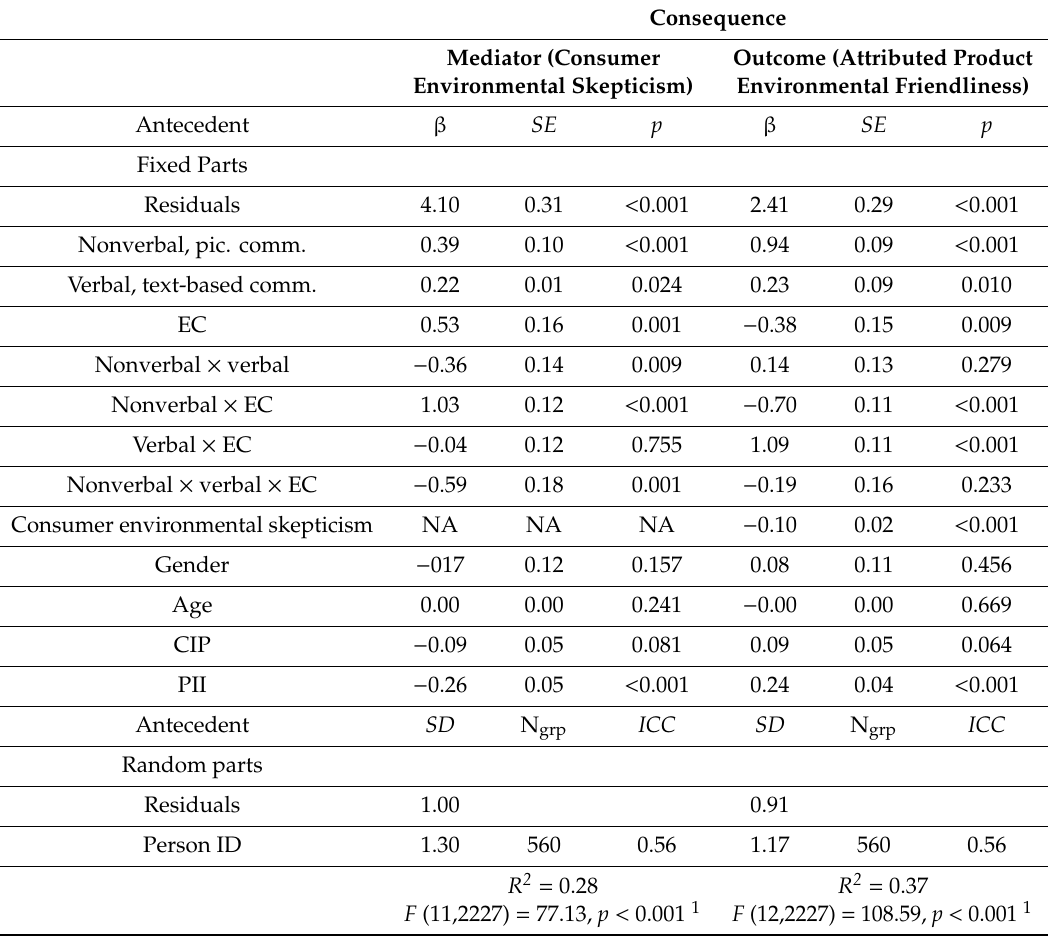
Table 1. First-stage moderated, moderated mediation model estimation. Independent variables: nonverbal and verbal packaging information and EC level. Dependent variables: consumer environmental skepticism and environmental